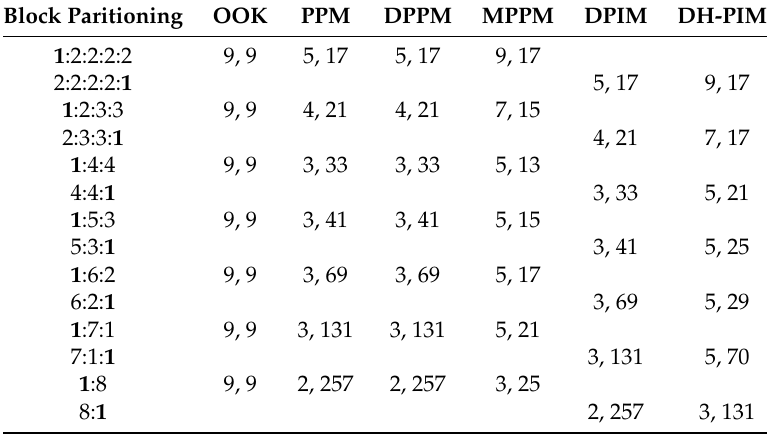
Table 11. Possible block partitioning according to block partitioning and modulation techniques. A bold ‘ 1 ’ shows a leading ‘1’ or a trailing ‘1’. Each cell expresses the modulated results as a 2-tuple Block Paritioning OOK